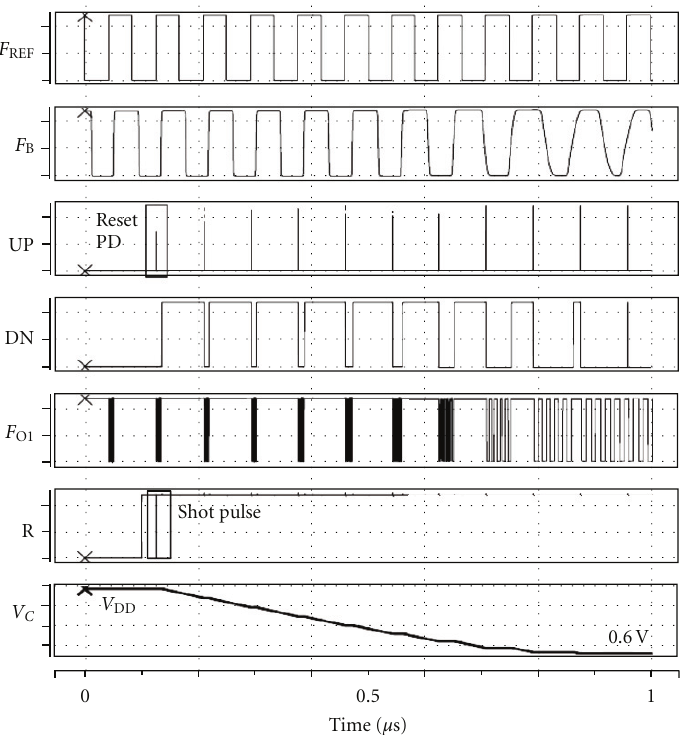
Figure 25: Postlayout simulation results from DLL1 locking operation. The simulation condition is tt/1.2V/25 ◦ C.